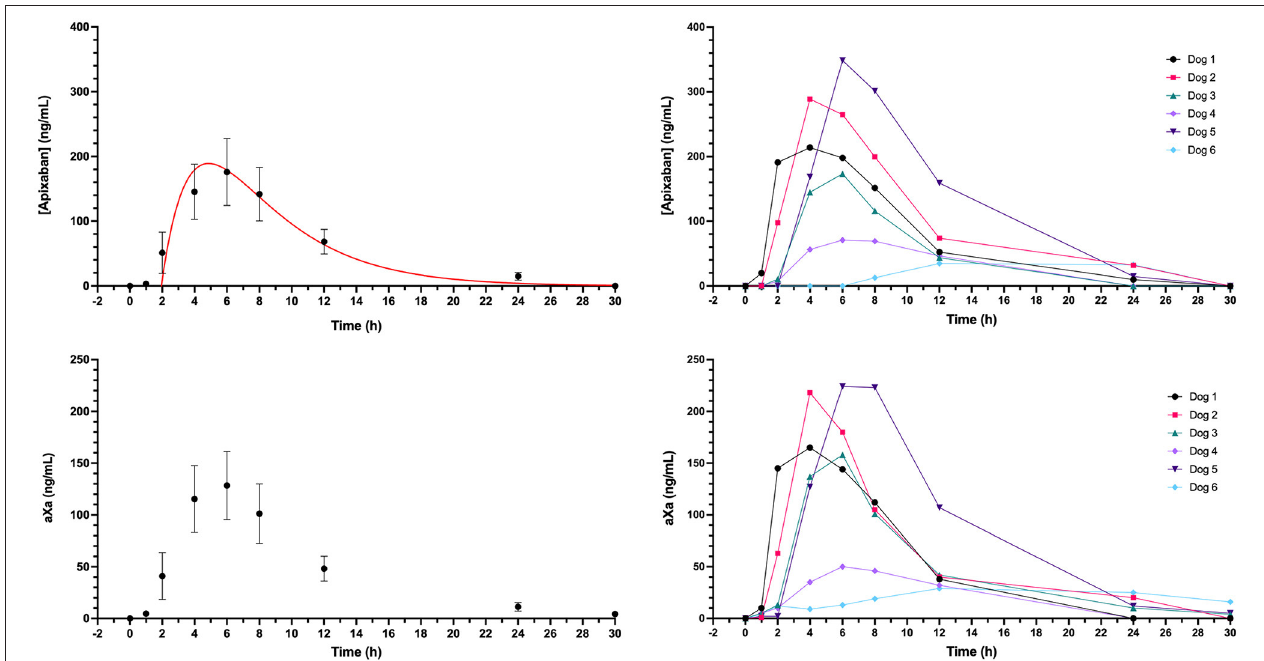
FIGURE 5 | Plasma concentrations and corresponding anti-Xa activity values (aXa) over time following oral administration of apixaban (0.2 mg/kg) to six healthy mixed-breed dogs. Data presented on the left panels represent mean ± standard deviation values, while data on the right panels are from each dog individually. Where the standard deviation values were smaller than the width of the dot, the error bars are not displayed. Red lines represent the fit line from the one-compartment pharmacokinetic model (see equation in section Materials and Methods) plotted using mean data ( Table 3 ).